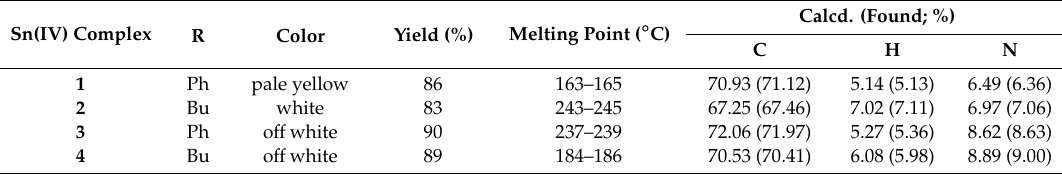
Table 1. Physical properties and elemental analysis of 1 – 4 .